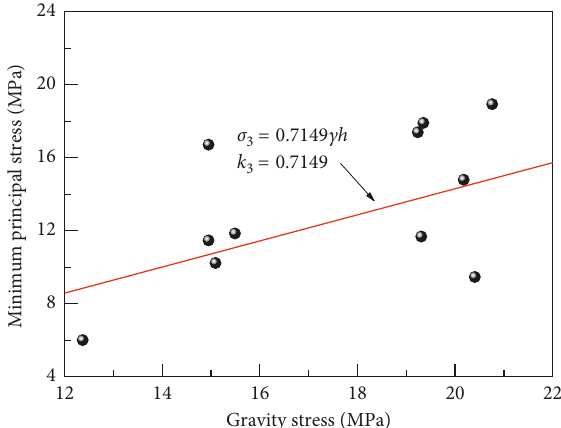
Figure 4: Relationship between minimum horizontal principal stress and gravity